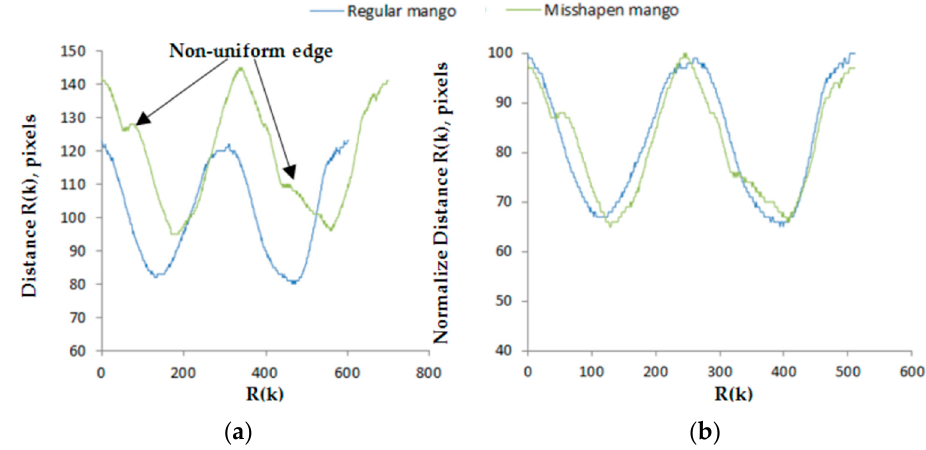
Figure 8. Distance signature of regular mango and misshapen mango with non-uniform edge. ( a ) Raw distance R(k) from the centroid to the boundary points; ( b ) Distance signature is normalized by 100 while number of distance point normalized to 512 points. It shows that the presence of non-uniform edge has affected the boundary profile.